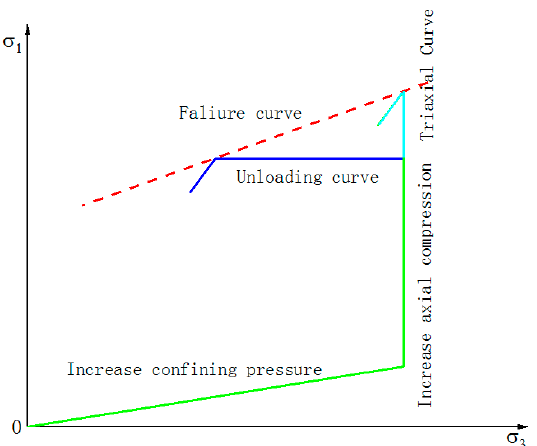
Figure 7. Triaxial unloading curve.